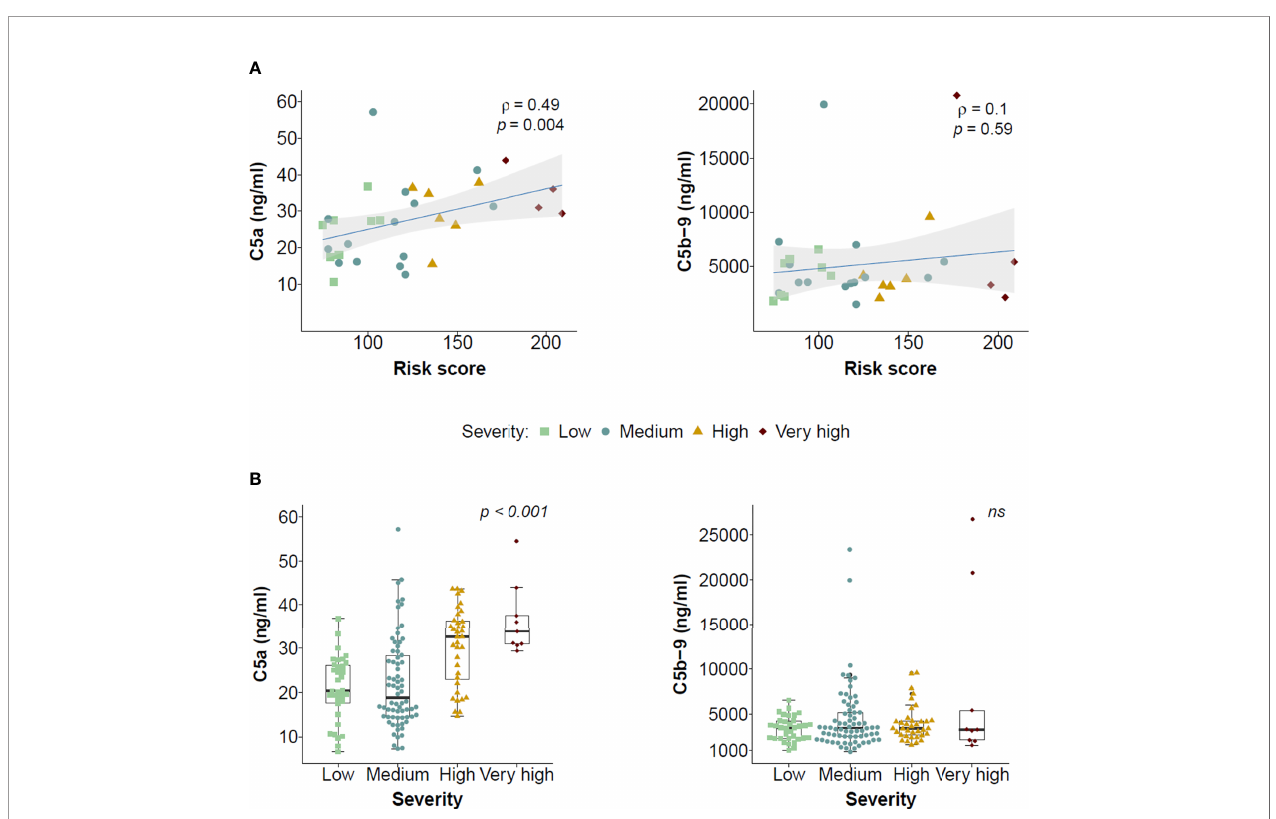
FIGURE 1 | Association of serum levels of C5a and C5b-9 with disease severity outcome in hospitalized COVID-19 patients. (A) Correlation between the levels of C5a or C5b-9 in the fi rst serum sample collected after hospitalization and a clinical risk score calculated for each patient. The correlation coef fi cients, the statistical signi fi cances of the Spearman ’ s test and the 95% con fi dence intervals (shadowed areas) are shown. The severity group at which each patient was assigned is also shown. (B) Association between serum C5a and C5b-9 levels in the fi rst serum sample collected after hospitalization and severity of the disease. Statistical differences were analyzed using the Kruskal-Wallis